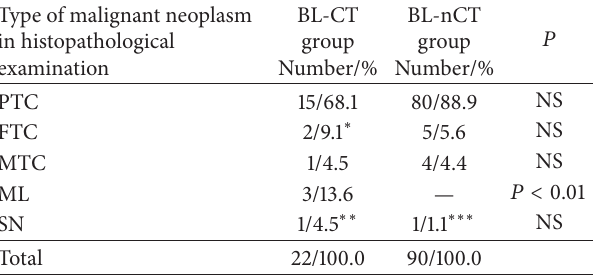
Table 3: Type of malignant neoplasms revealed in postoperative histopathologicalexaminationinthepatientsofBL-CTandBL-nCT